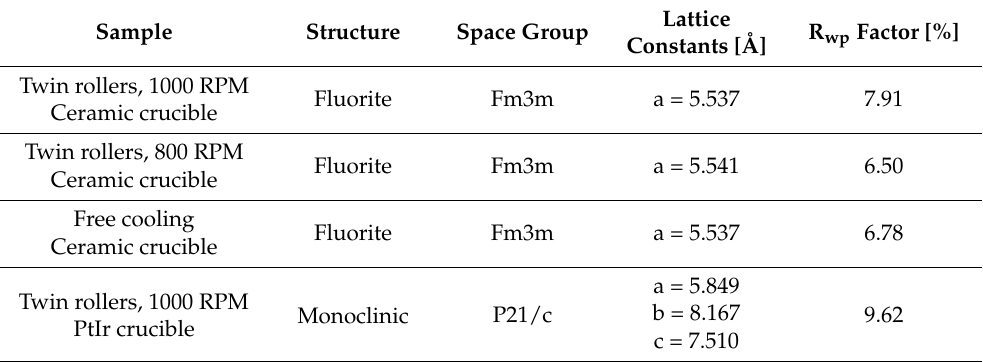
Table 2. Results of calculations by the Rietveld method for samples melted at 1000 ◦ C. Sample